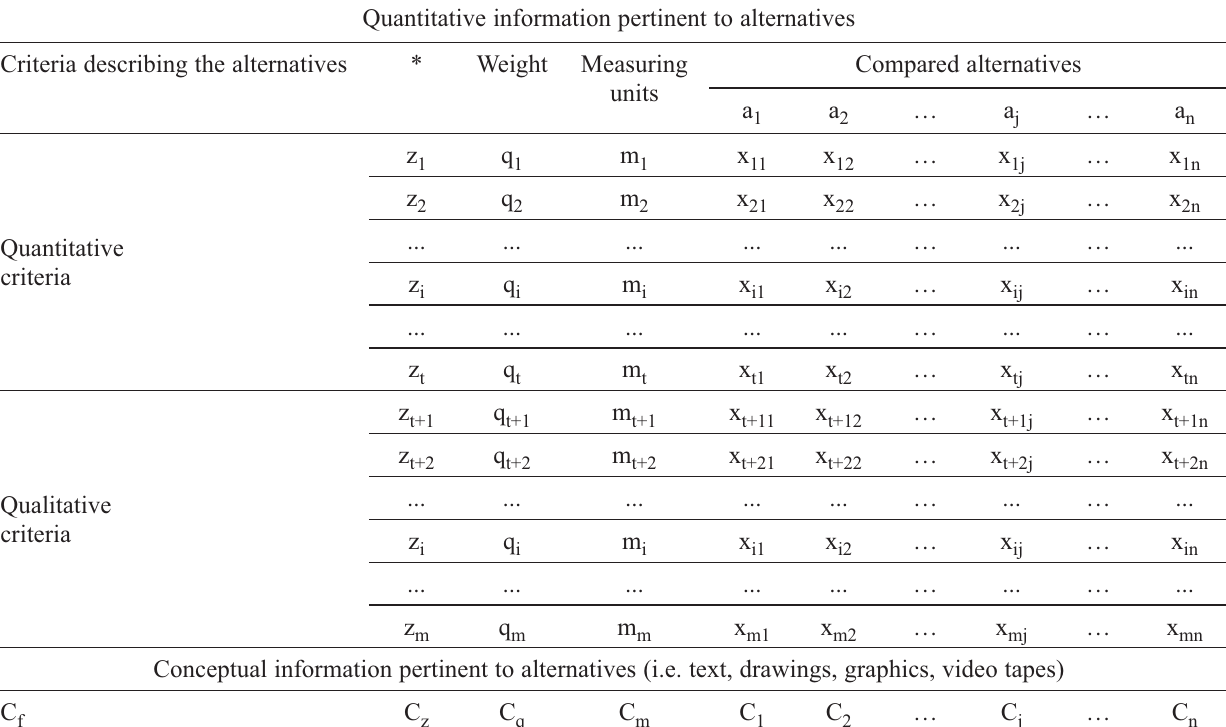
Table 1. Grouped decision-making matrix of alternatives multiple criteria